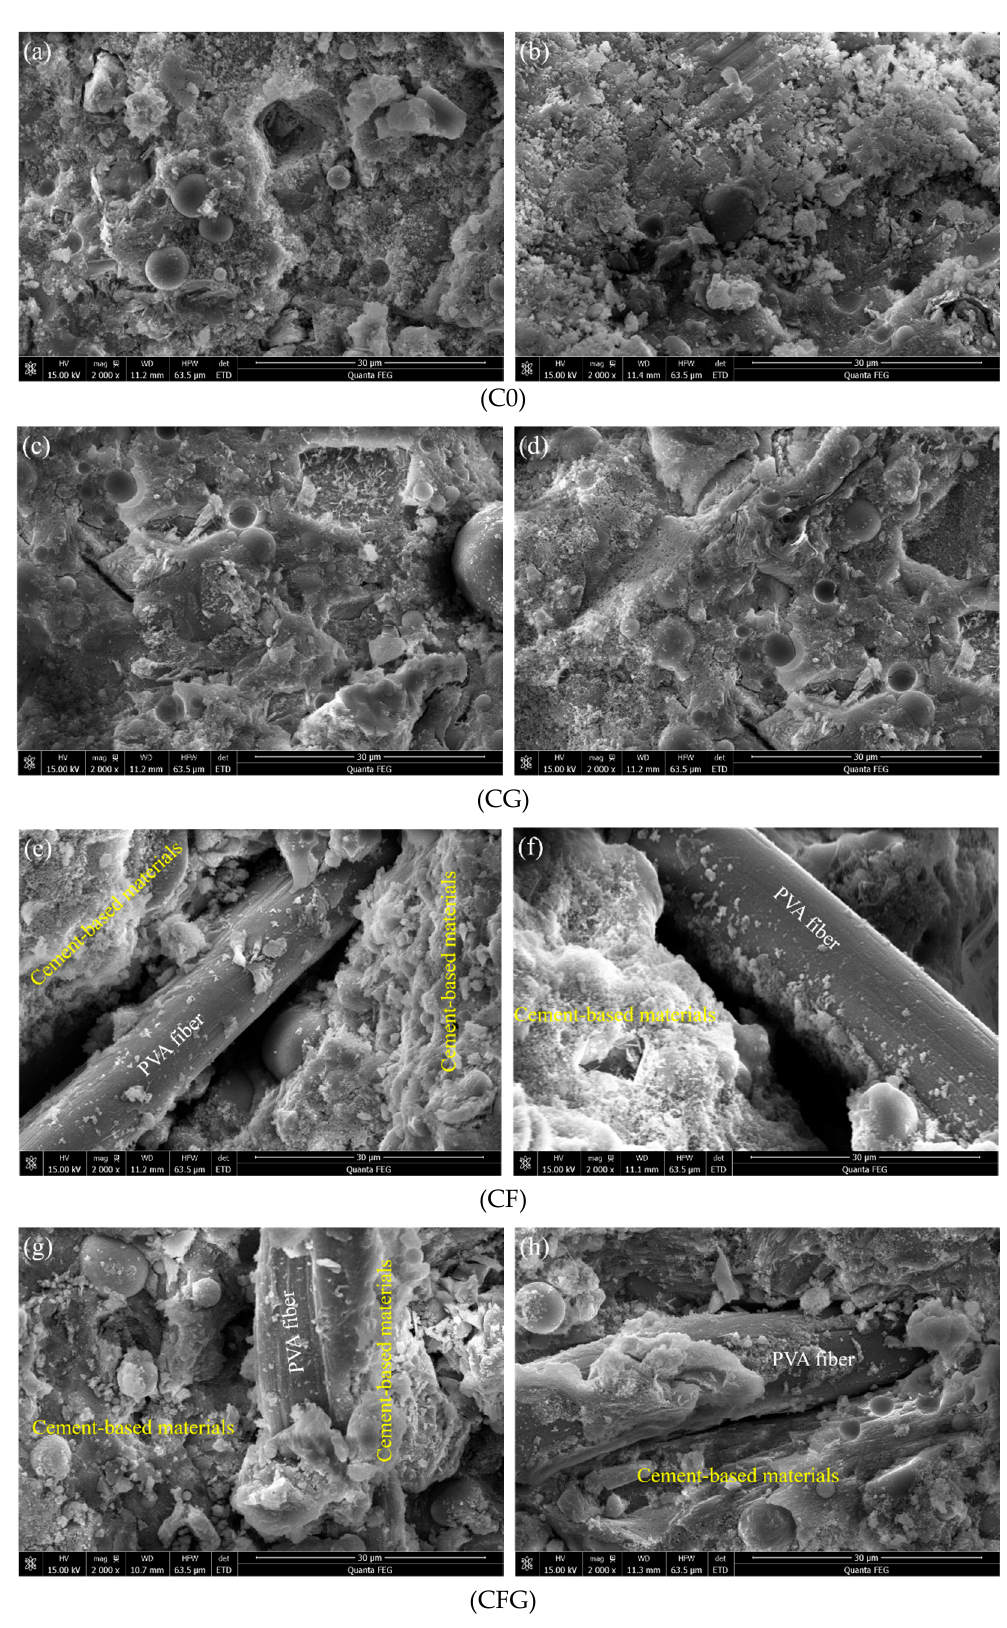
Figure 9. Microstructure morphology of hardened specimens at 28 d age at 2000 magnification; ( a , b ) control sample; ( c , d ) GO modified sample; ( e , f ) PVA fiber modified sample; ( g , h ) GO coupling with PVA fiber modified sample.